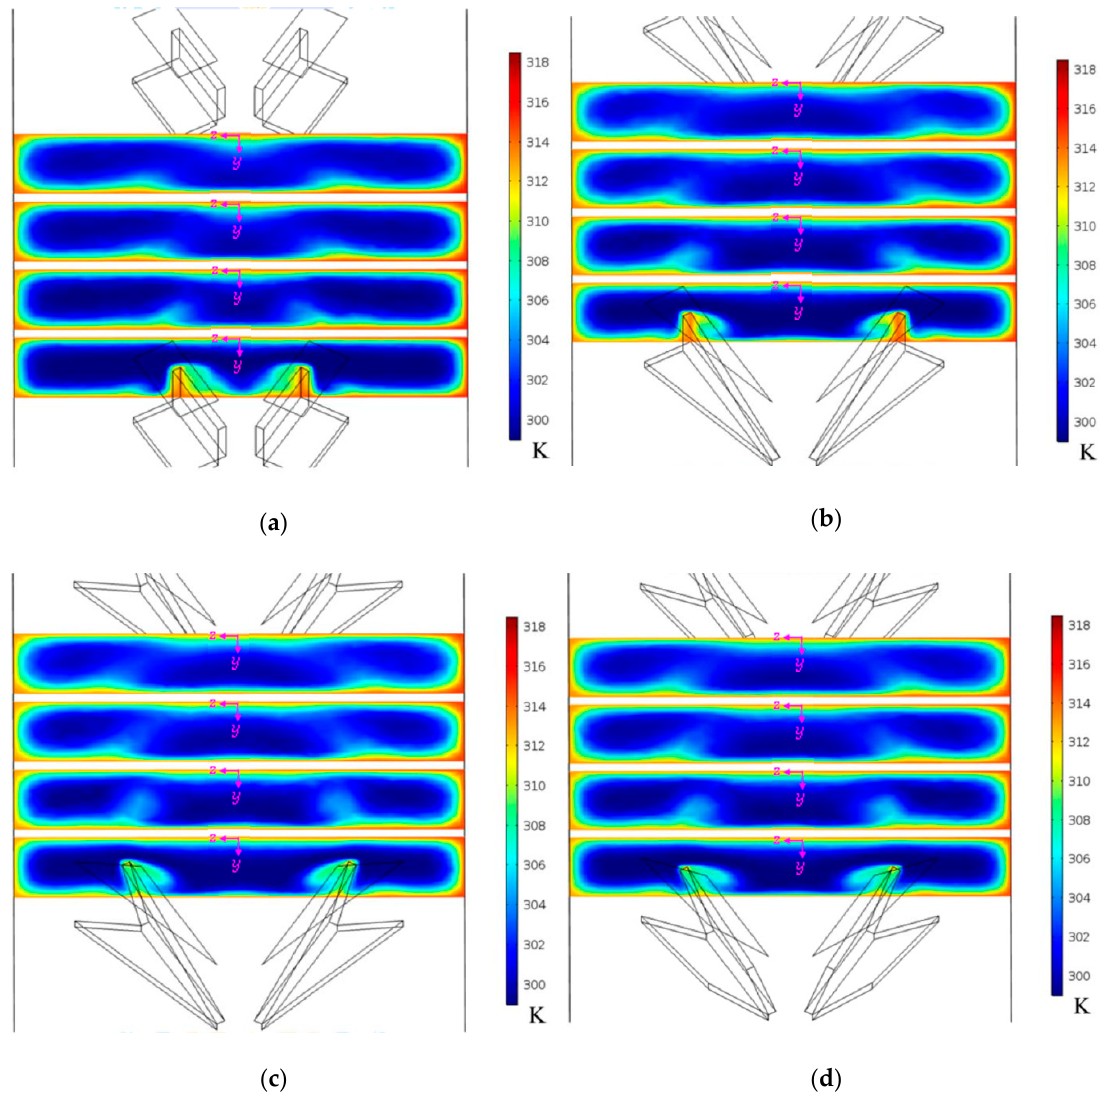
Figure 9. The air temperature distribution in several yz planes of the plate-fin heat sinks having (a) RWP, (b) DWP, (c) SDWP, and (d) STWP VGs at airflow velocity of 5 m/s.